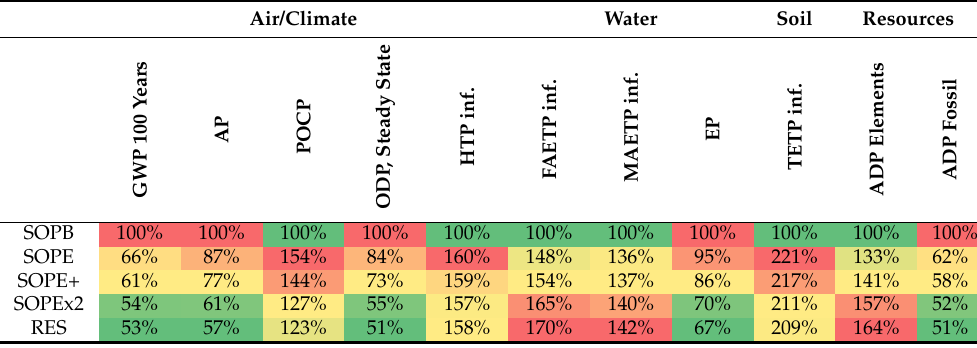
Table 8. The reduction/increase in the environmental impact indicators according to the